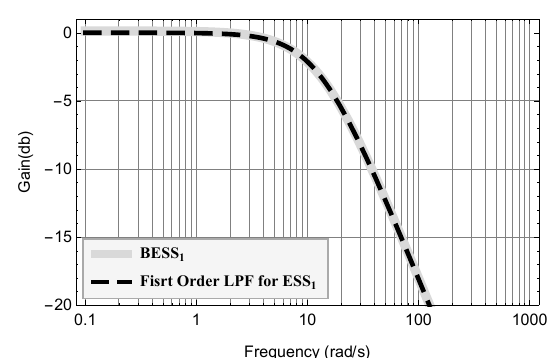
Figure 15. Overall dc power injections for ESS 1 and ESS 2 .